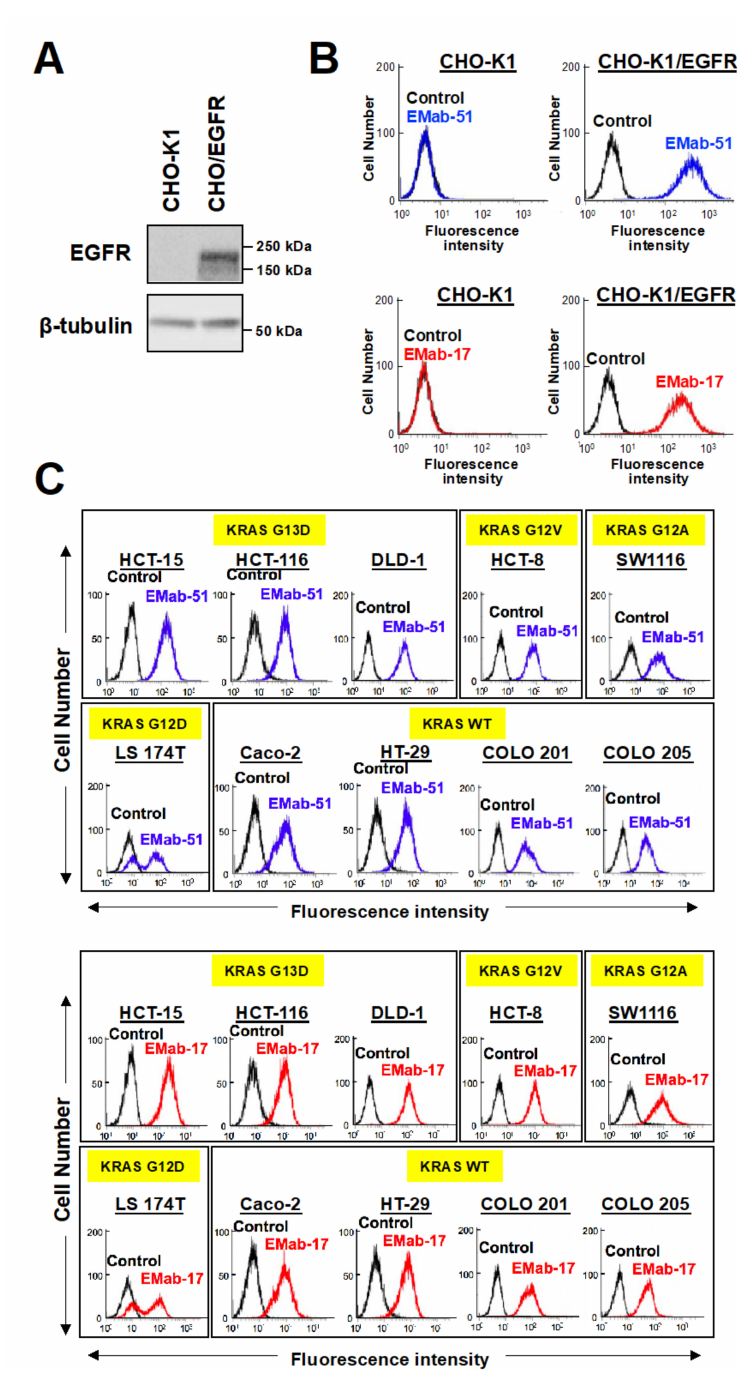
Figure 1. Flow cytometry of epidermal growth factor receptor (EGFR)-transfected and EGFR-expressing cell lines using anti-EGFR antibodies EMab-17 and EMab-51. ( A ) CHO-K1 and CHO / EFGR cells were subjected to Western blotting analysis with an anti-EGFR or anti- β -tubulin antibody. ( B ) CHO-K1 and EGFR-transfected CHO-K1, CHO / EGFR cells were treated with 1 µ g / mL of anti-EGFR antibodies, EMab-51 ( Left ; blue) and EMab-17 ( Right ; red). After treatment with the anti-EGFR antibodies, the cells were treated with Alexa Fluor 488-conjugated anti-mouse IgG; black line, negative control. Fluorescence data were collected using a Cell Analyzer EC800. ( C ) CRC cell lines with or without KRAS mutations were treated with EMab-51 ( Top ; blue) and EMab-17 ( Bottom ; red). Yellow highlights indicate the KRAS status of CRC cell lines. Data were analyzed as in ( B